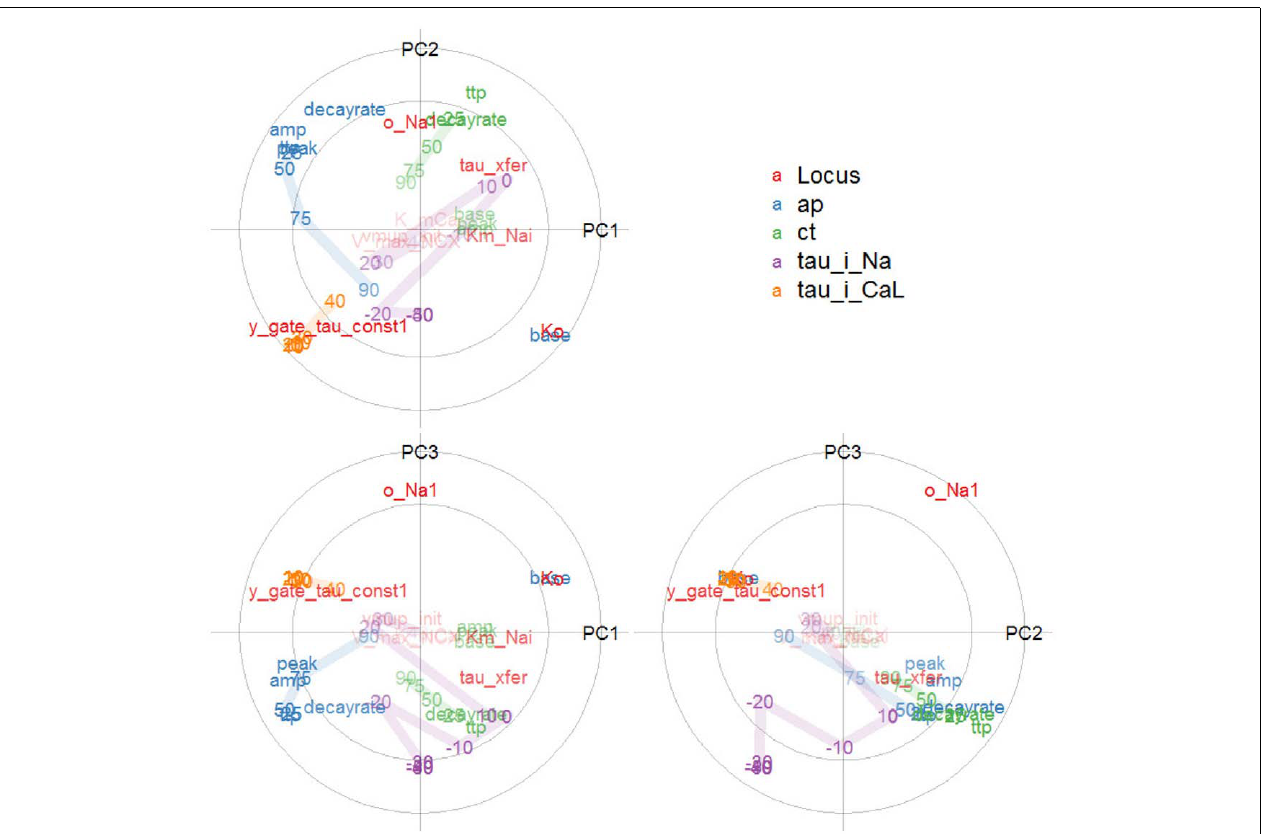
variance explained by the pair of components; labels near the center are dimmed.Variable identifiers are centered over their respective points. For the action potential (AP) and calcium transient (CT),TTP means time to peak, and lines connect the phenotypes for time to 25, 50, 75, 90% recovery. For the voltage-clamp phenotypes, lines connect the range of transmembrane voltages to which a cell was